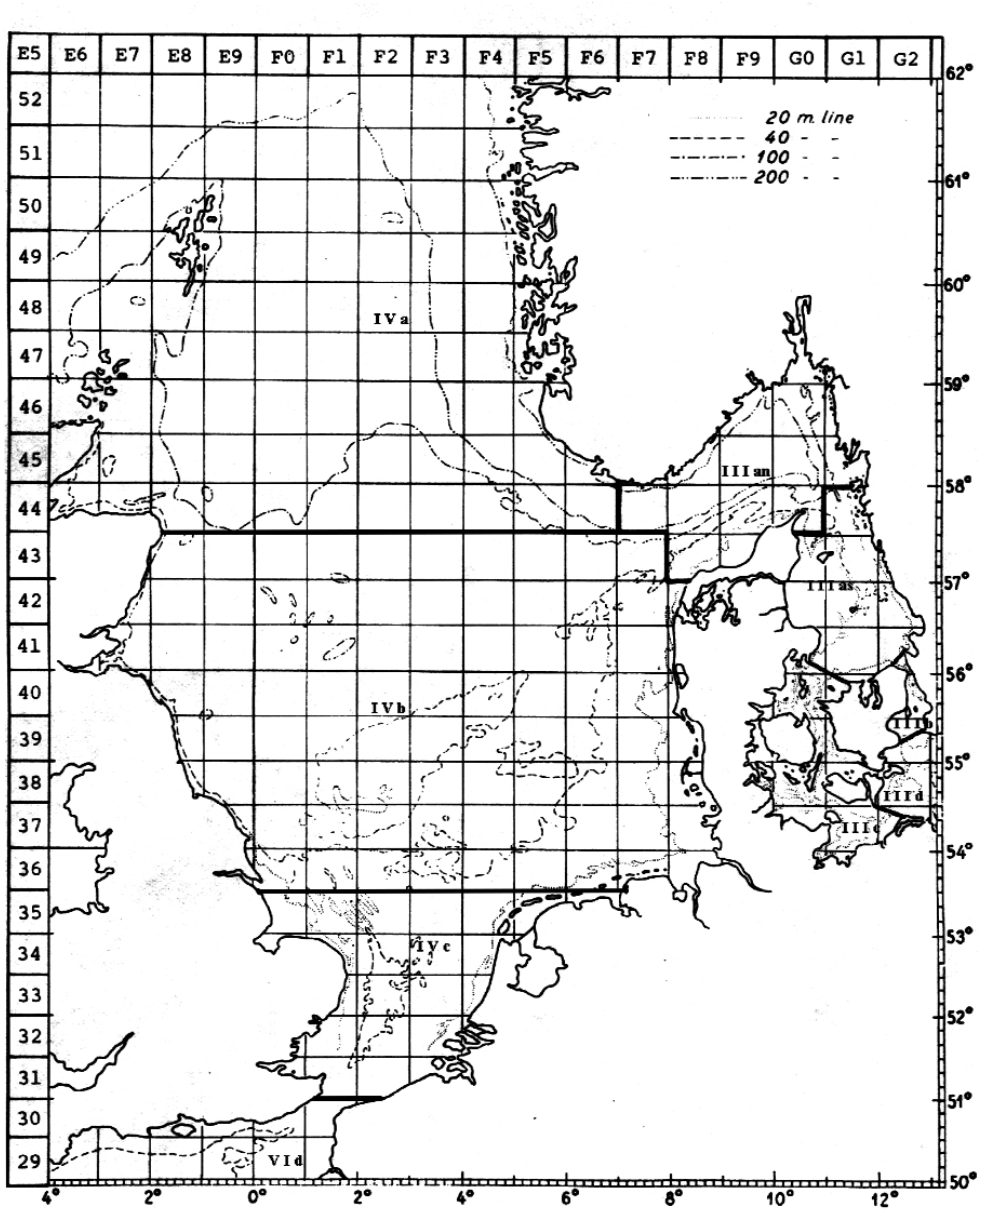
Fig. 1. Map of the North Sea and Inner Danish waters, together with ICES areas and squares, latitude North and longitude West and